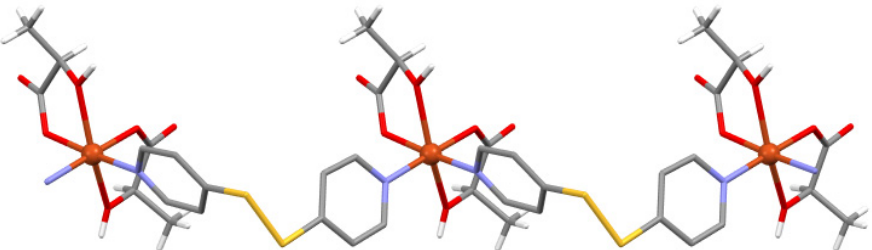
( μ - dtdp )·4H O] (TOKDUT), showing the P form 2 2 n units. 2